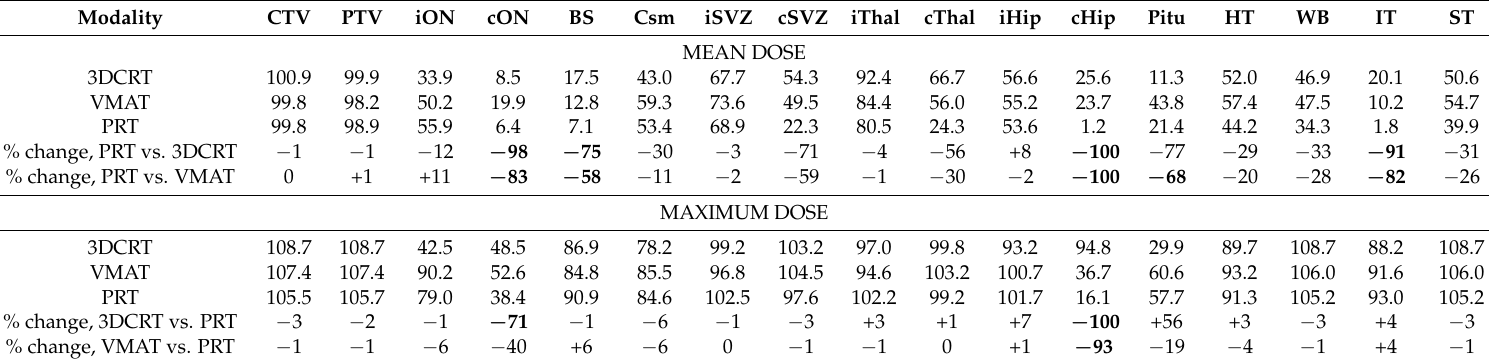
Table 2. Median values for mean and maximum doses to target volumes and organs-at-risk by radiotherapy modality for frontal tumors. Modality